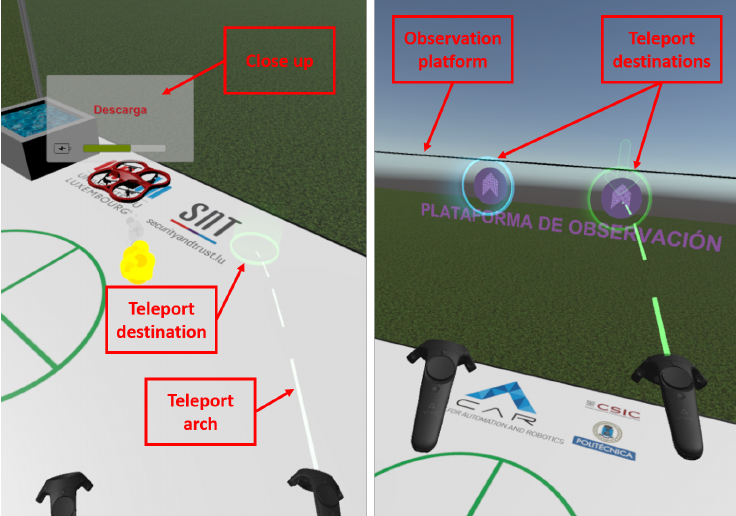
Figure 10. Teleport to floor ( left ) and observation platform ( right